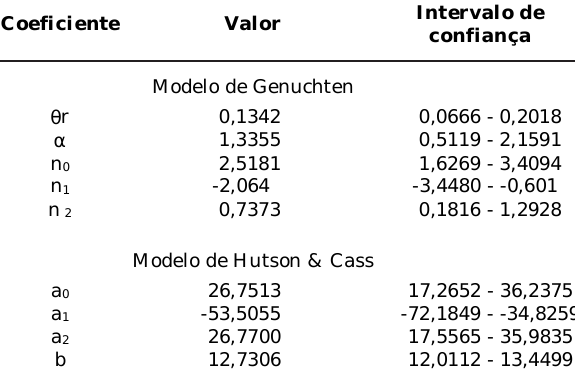
Figura 2. Distribuição dos resíduos produzidos pelo ajuste das funções de VG (a) e HC (b) após a descrição dos parâmetros n e a pela densidade do